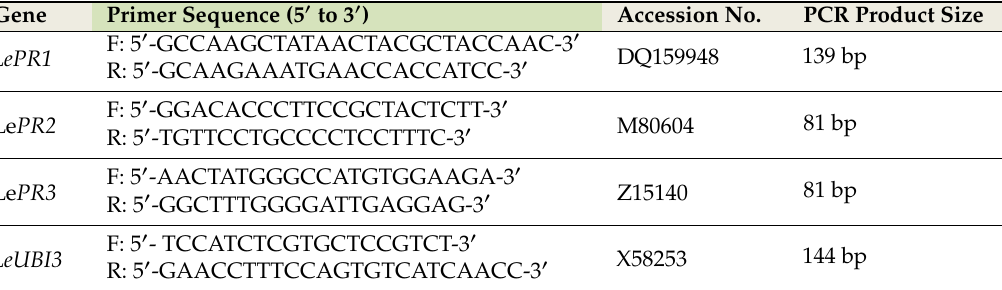
Table 2. Gene specific primers were used for real-time PCR in this